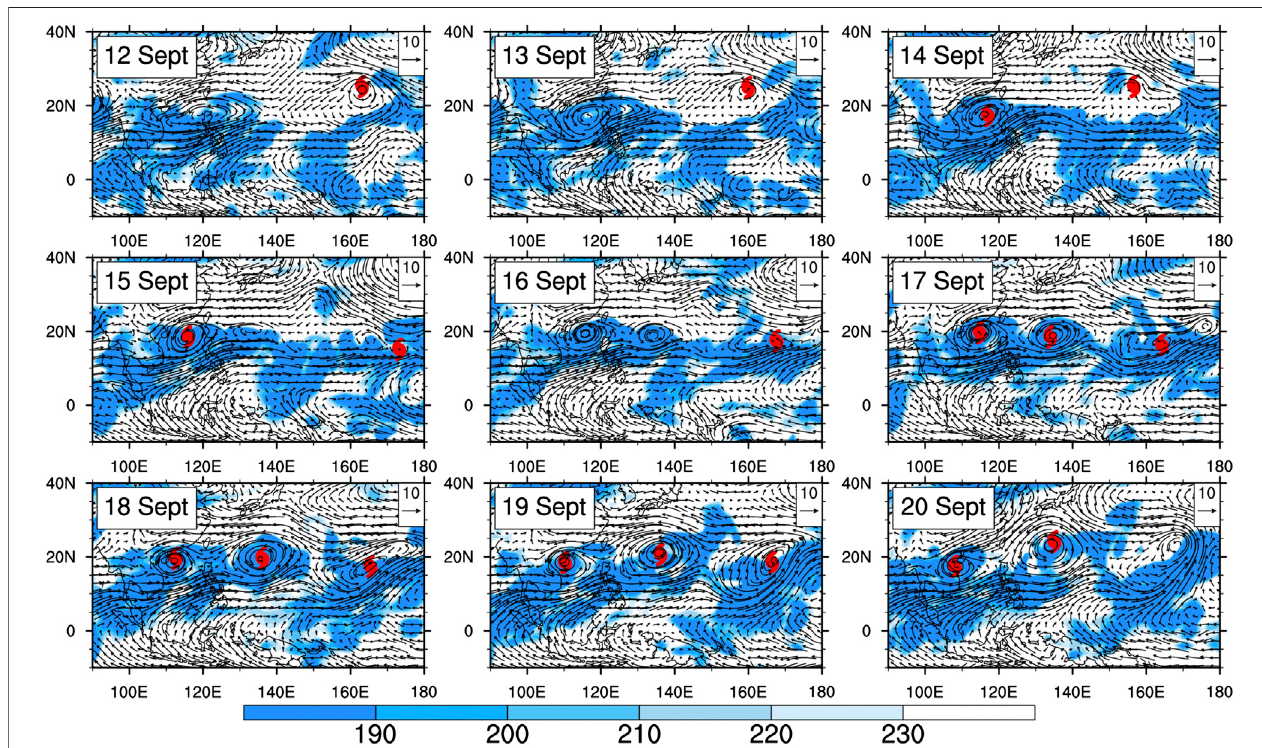
FIGURE6 | Evolution ofthe OLR and 850 hPa wind fi elds from 12to20 September. The dateisgiven in theupper leftcorner ofeach panel, and the position ofthe individual TCs is indicated by the tropical cyclone symbol.